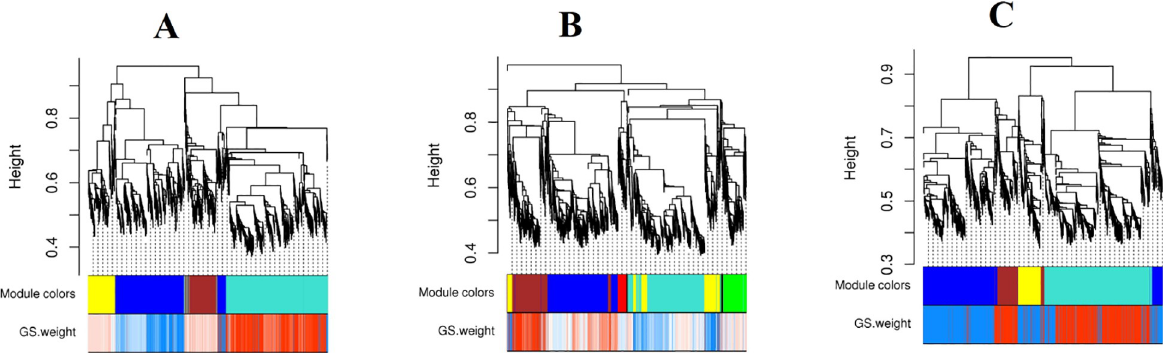
Fig 5. Visual representation of the changes in the module structure between LG (A), TR (B), and PR (C) phases. Modules are illustrated with different colors.